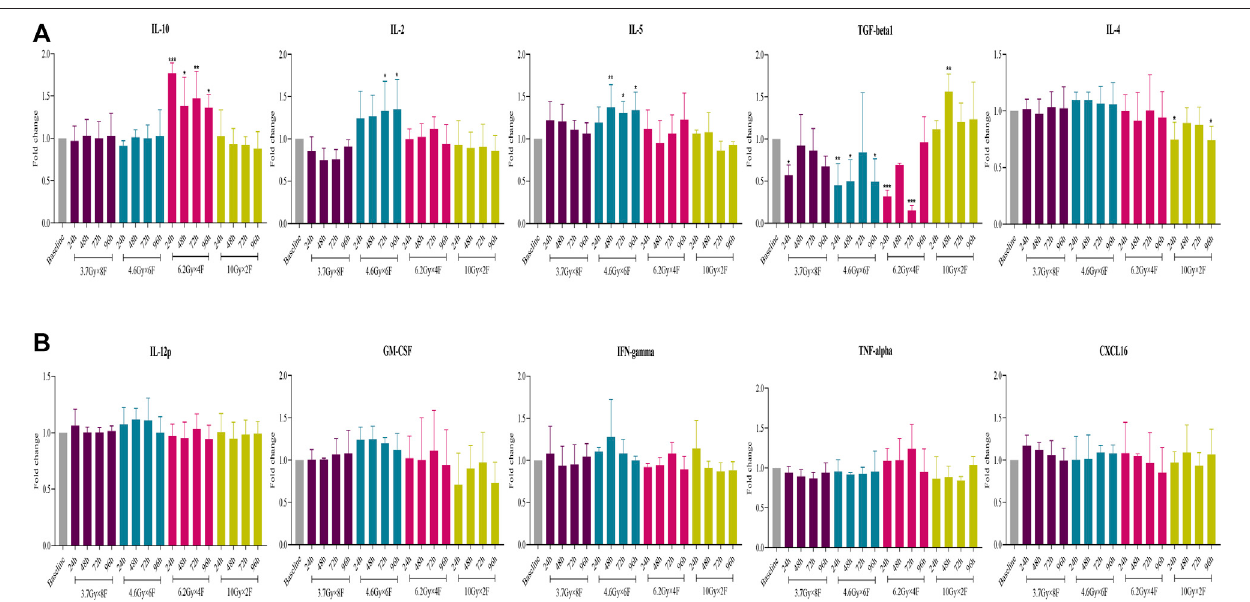
FIGURE 7 | Changes of cytokine expression after radiotherapy in peripheral blood of NSCLC patients. (A) Expression of IL-10, IL-2, IL-5, TGF- β 1, and IL-4 had differentchangesafter 4fractionation radiotherapies. (B) No signi fi cantchange on IL-12p, GM-CSF, IFN- γ ,TNF- α ,and CXCL16 between pre and post-radiotherapy.* p ＜ 0.05,** p ＜ 0.01, *** p ＜ 0.001, compared with